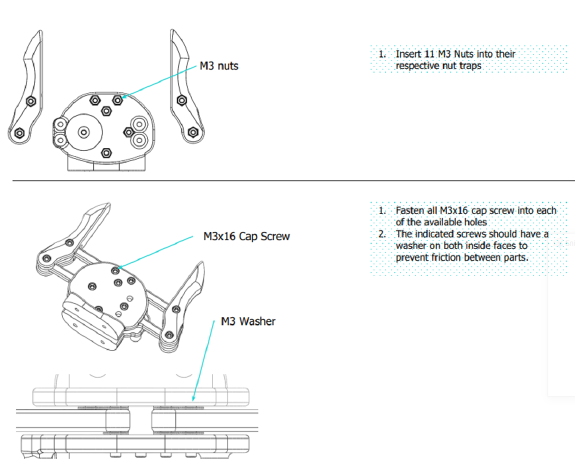
Fig. 7. Design for gripper assembly